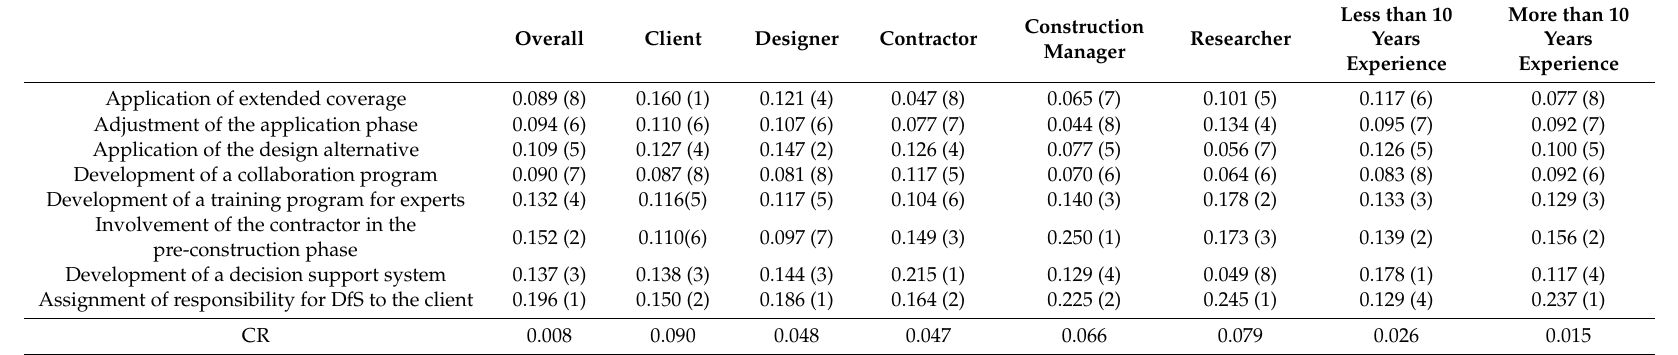
Table 7. Results of the F-AHP analysis of the importance of the DfS improvement